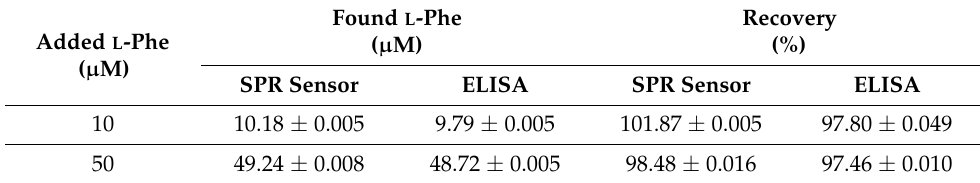
Figure 8. Sensorgram for real-time L -Phe detection ( A ) and calibration curve ( B ) of different L -Phe concentrations (1.0–100 µ M) in 1/5 diluted artificial plasma. Table 3. The recoveries of L -Phe in artificial plasma samples